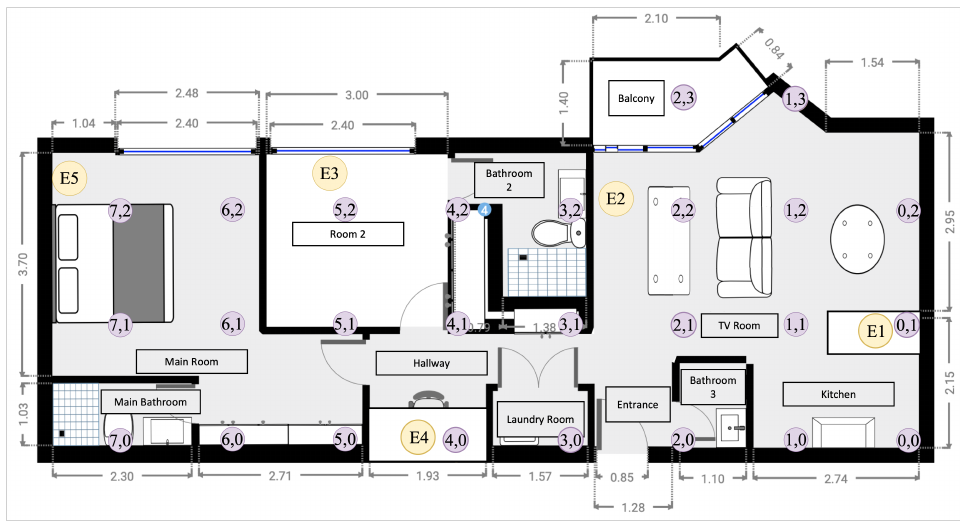
Figure 9. Floor plan of the space under analysis, showing the scanning stations (yellow circles) and predefined locations for the TAGs (labels). Adapted from